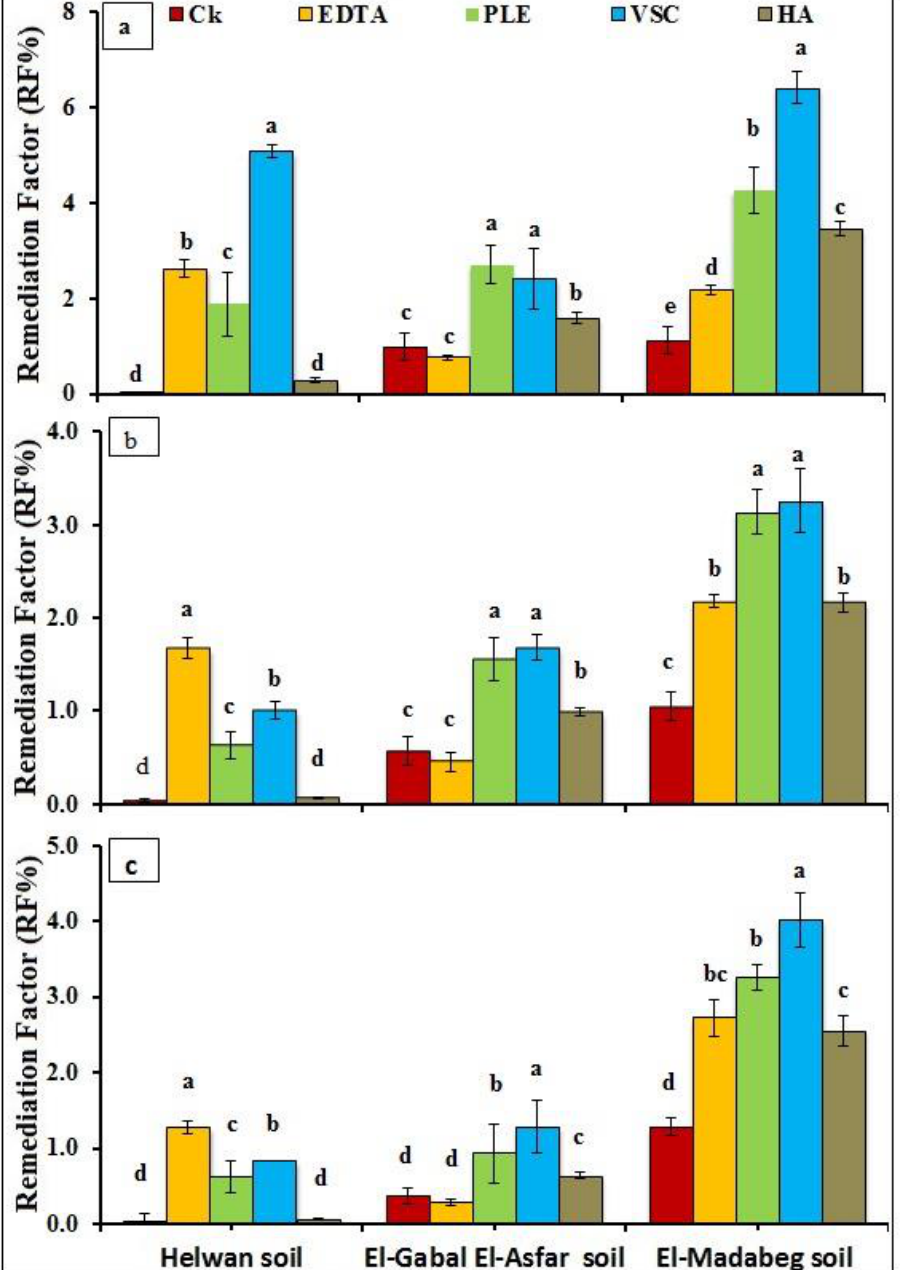
Figure 3. The remediation factor (RF%) of Pb ( a ), Zn ( b ) and Cu ( c ) by A. tricolor as affected by the application of different organic materials. CK (control, No additions), EDTA (Ethylene diamine tetraacetic acid at 2 mM), PLE (poultry litter extract at 75 g/L), VSC (vinasse 1:2 water) and HA (humic acid at 0.025%). Same letters were not significantly different at p < 0.05.